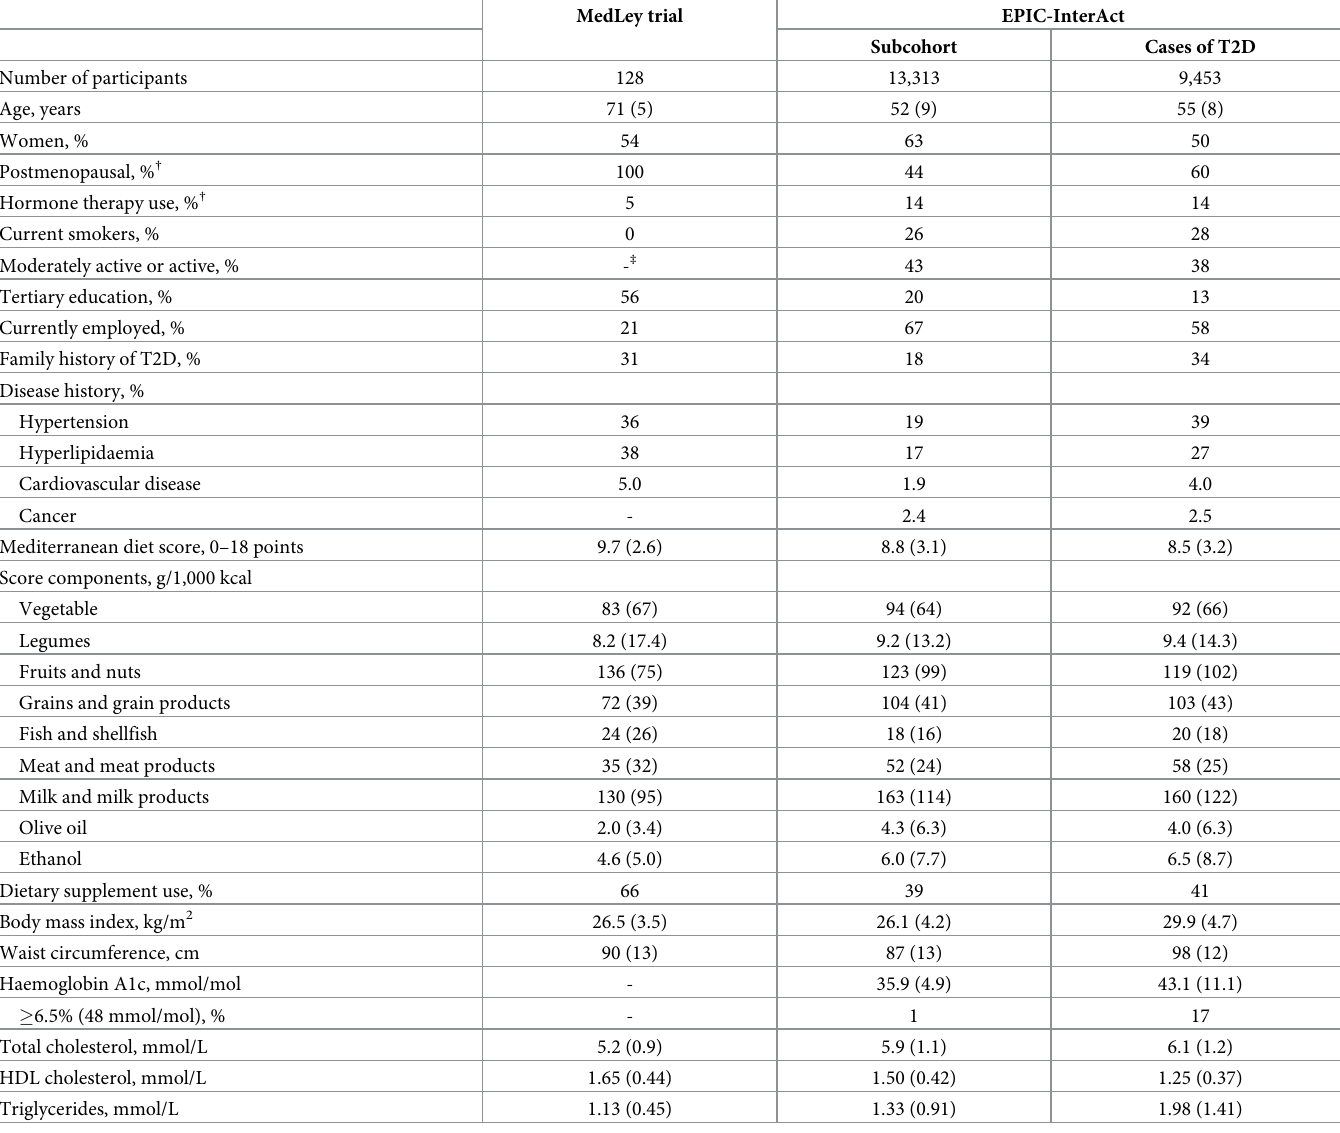
Table 1. Baseline characteristics of participants of the MedLey randomised partial-feeding controlled trial of the Mediterranean diet and the EPIC-InterAct case- cohort study * .